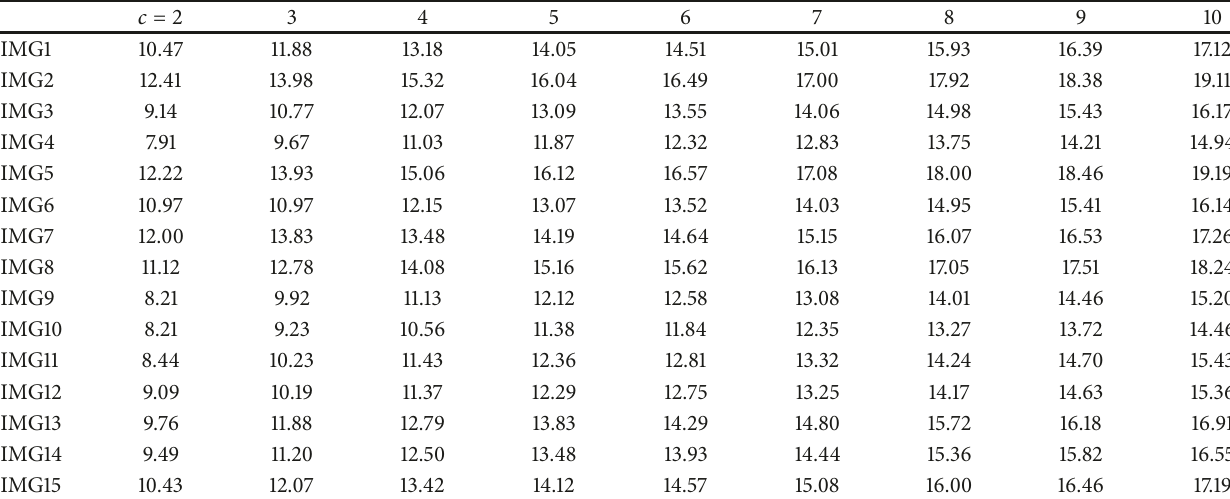
Table 12: PSNR using GK with different cluster number.